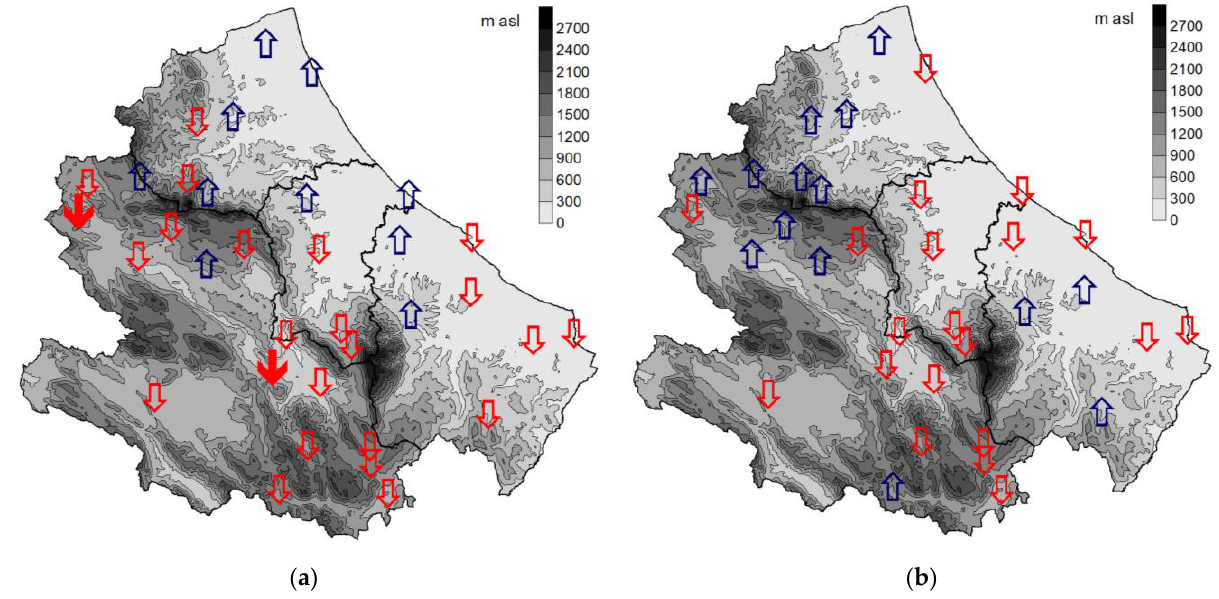
Figure 9. Spatial distribution of trend in SI series (1980–2018): ( a ) point data; ( b ) e-OBS data. Down arrows indicate decreasing trends, while upper arrows denote increasing trends. Solid arrows indicate significant trends ( p -Value < 0.10) according to Mann–Kendall test.